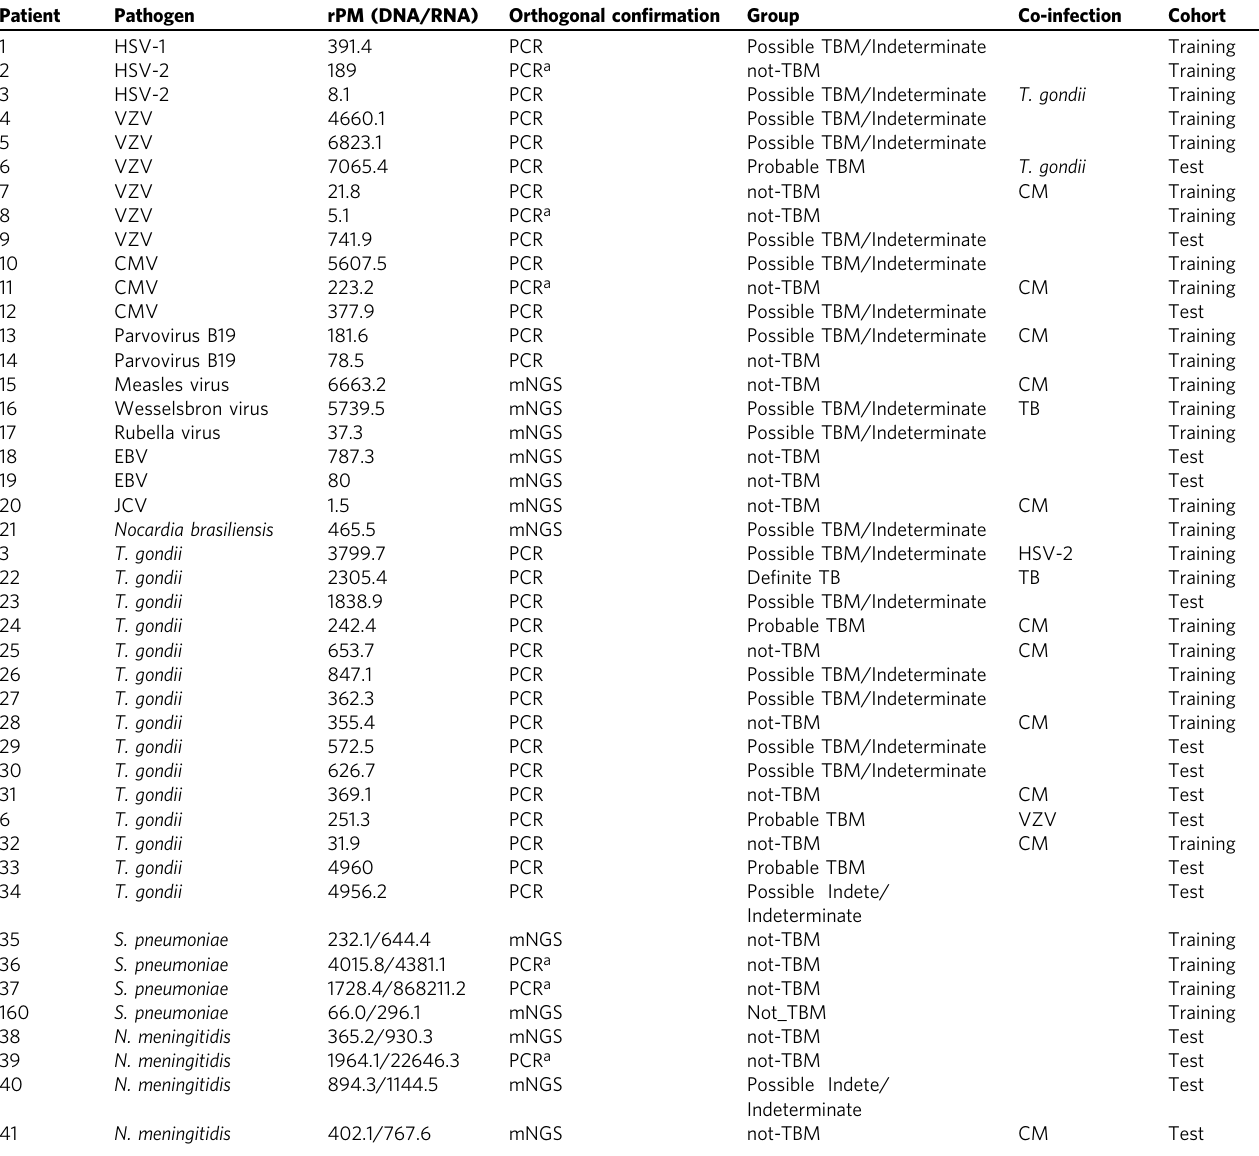
HSV herpes simplex virus, VZV varicella zoster virus, CMV cytomegalovirus, EBV Epstein-Barr virus, JCV JC virus, PCR polymerase chain reaction, mNGS metagenomic next-generation sequencing, TB Mycobacterium tuberculosis , CM cryptococcal meningitis. a Orthogonal testing con fi rmed with Bio fi